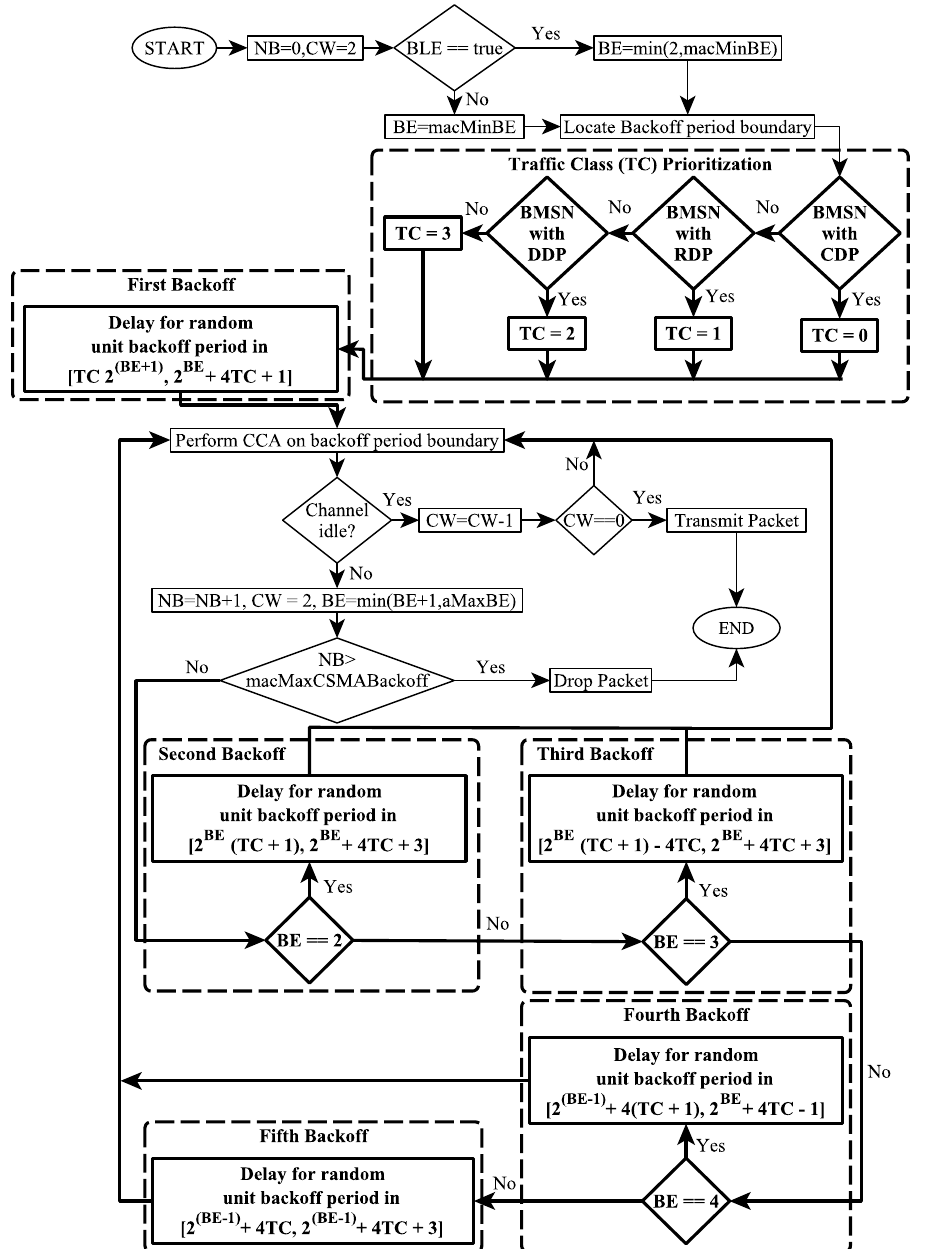
Figure 1. Flowchart of Traffic Class Prioritization based Carrier Sense Multiple Access/Collision Avoidance (TCP-CSMA/CA) scheme. The dotted blocks show the contributions made to assign a distinct, minimized, and prioritized backoff period range to each traffic class in every backoff.